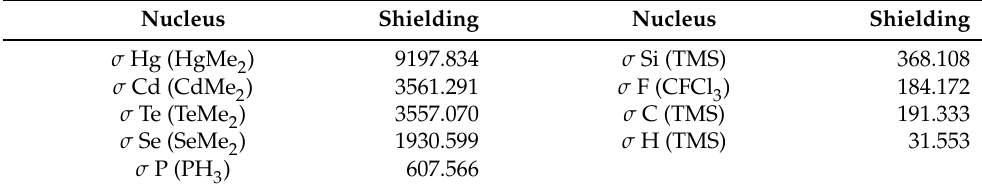
Table 1. 1 H, 13 C, 29 Si, 19 F, 31 P, 77 Se, 125 Te, 113 Cd, and 199 Hg NMR absolute shieldings, σ (ppm) of the ((Si(CH ) , TMS), CFCl , PH , SeMe , TeMe , CdMe , and HgMe reference molecules. Calculated 3 4 3 3 2 2 2 2 using the two-component ZORA approach with the PBE0 exchange-correlation functional and the TZ2P basis sets. Nucleus Shielding